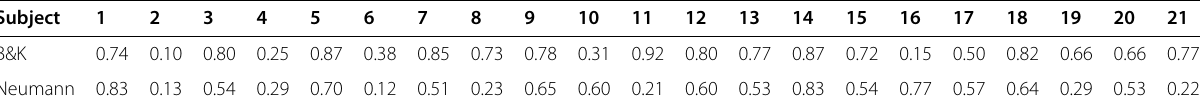
Table 4 R -squared values of quadratic regressions for calculating minimum error scaling factors, for each subject and